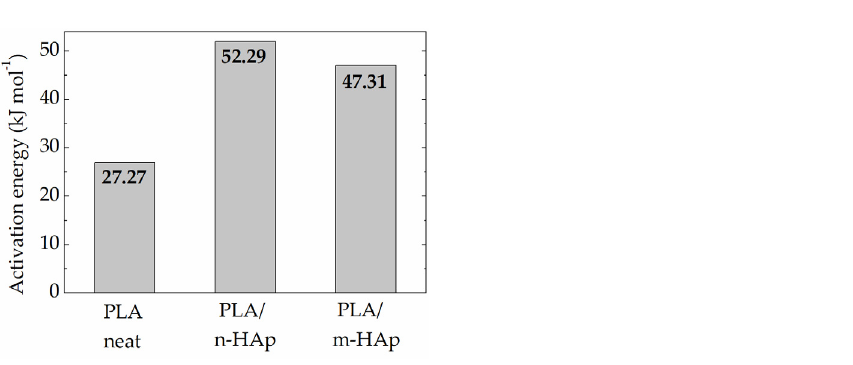
Figure 10. Activation energies for the thermal oxidation of unirradiated PLA/HAp hybrid. Filler loading: 2% [160].